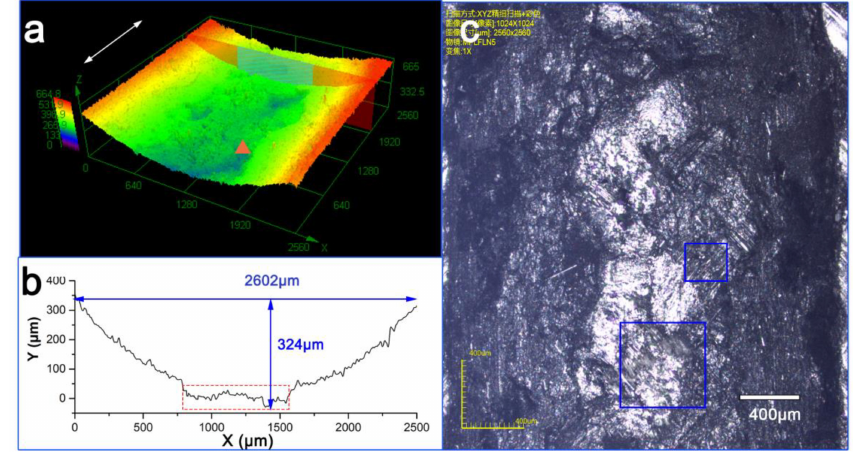
Figure 11. Morphology of worn surface of C-0.4 g after 60-min wear test: ( a ) 3D surface topography, ( b ) surface profile, ( c ) optical image of worn